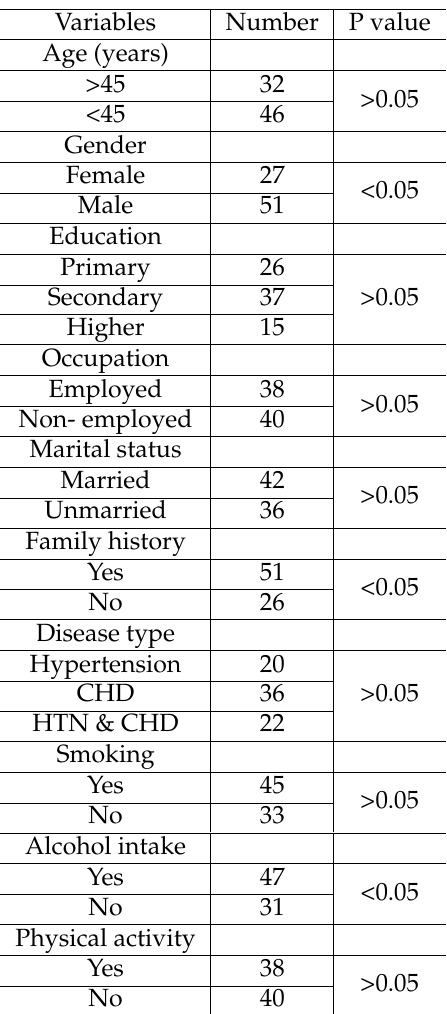
Table 1. Patient characteristics